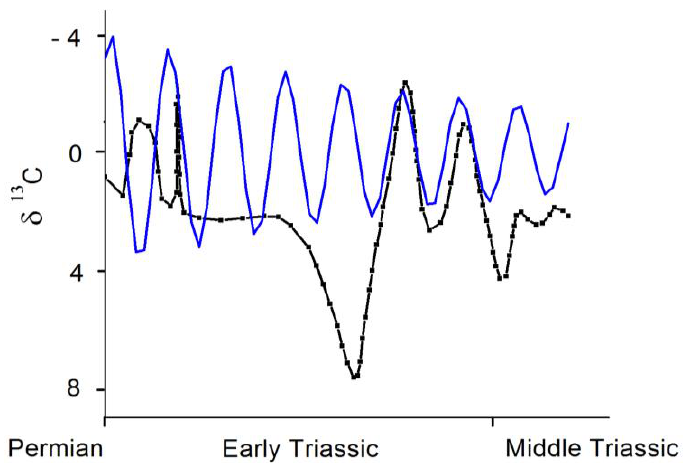
Figure 2. A comparison between the Green function response Equation (5) (blue curve) with the time-resolved data corresponding to the Permo-Triassic extinction event analyzed by Burgess, Bowring and Shen [23] (black curve). The origin of the time axis has been set to the end of the extinction interval given by these authors. See the text for